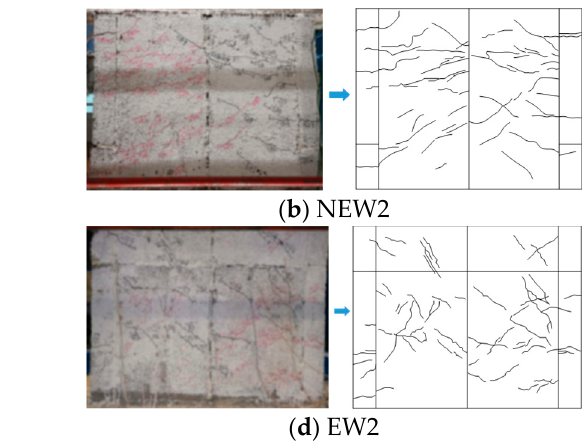
Figure 7. Failure modes of the specimens.